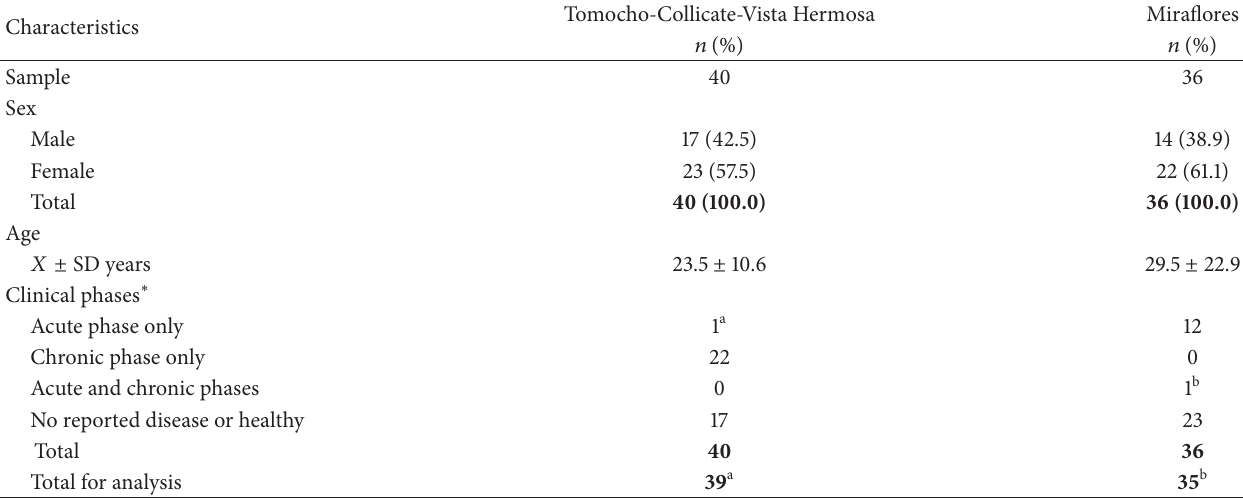
Table 1: General data and clinical phases of the samples analyzed in this